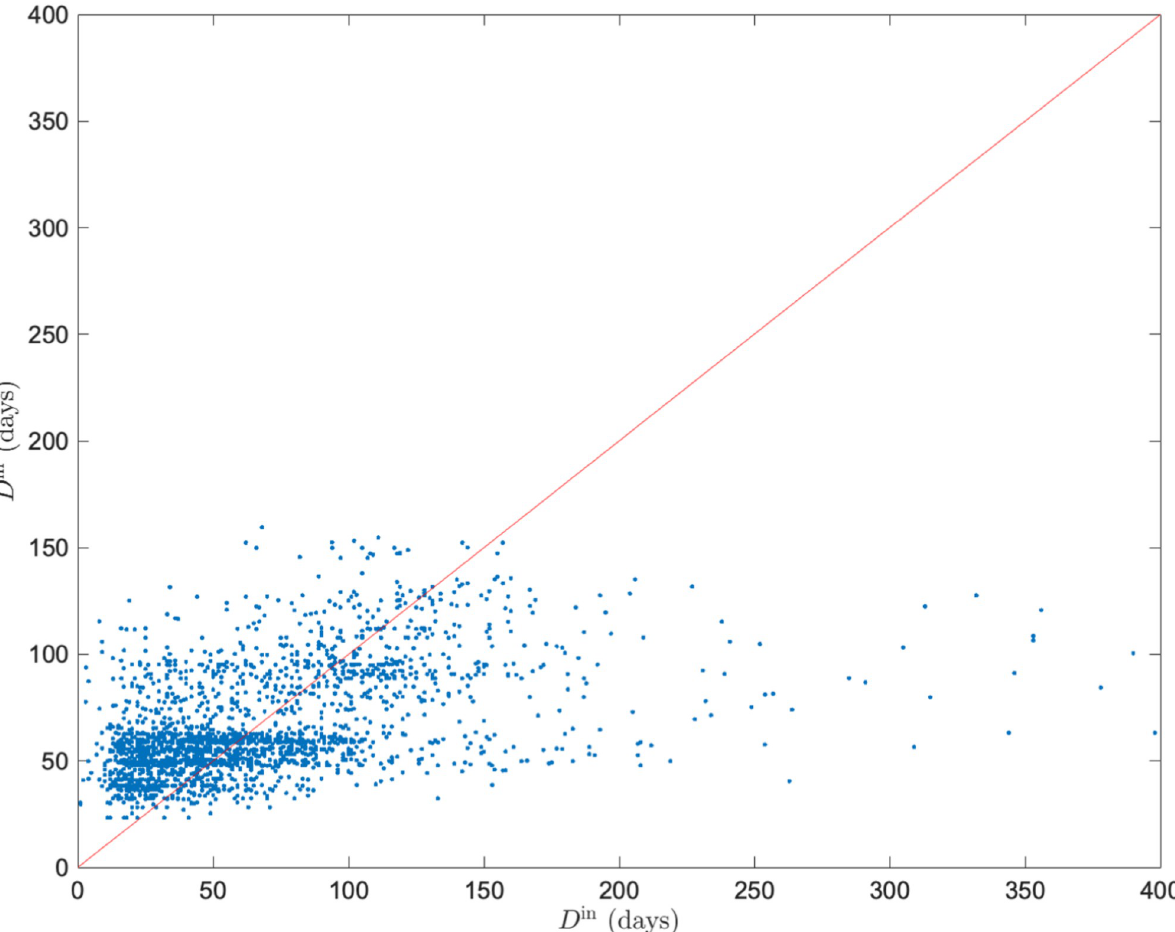
Fig 11. Comparison of measured duration of hospital stay D in and predicted duration of hospital stay D in calculated by regression tree ensemble model. The predicted and measured values calculated by the regression tree ensemble model with the average value of μ ( v ) of the feature representations by node2vec as the input variable. We select the best result comparing the coefficient of determination R 2 among all sets extracted through 300 iterations ( R 2 = 0.24).